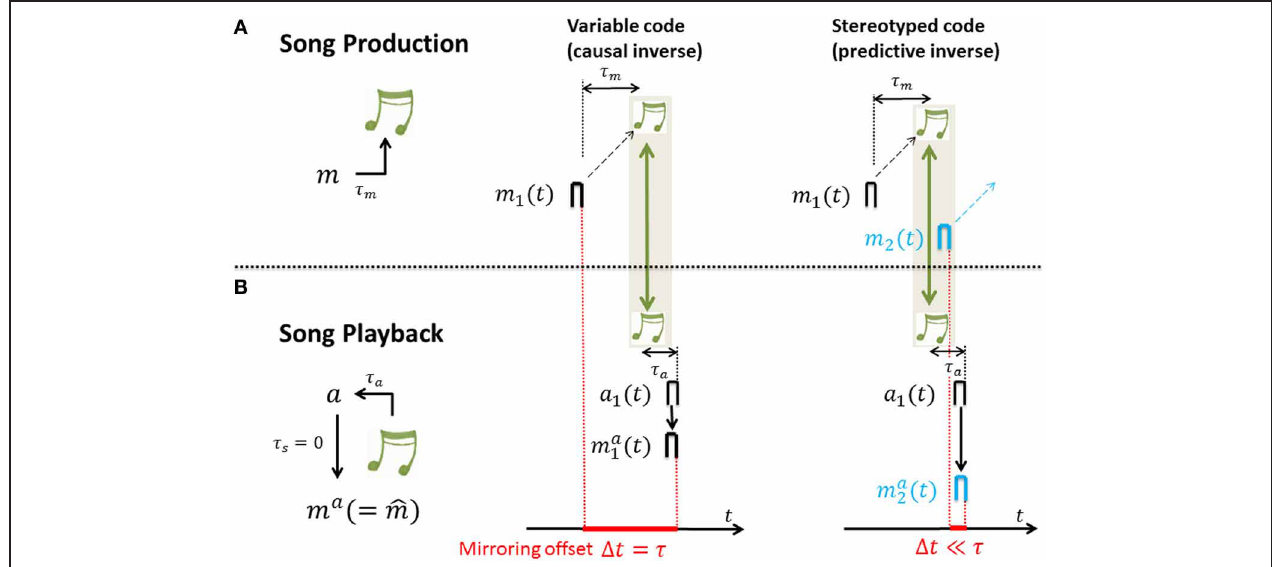
FIGURE 4 | The mirroring offset is determined in recordings of neural activity across (A) singing and (B) auditory stimulation by song playback; the offset (red) is large for causal inverses (middle column) and close to zero for predictive inverses (right column). (A) During singing, a motor-neuron burst m 1 drives a song feature (green notes) after a time delay τ m . (B) Playback of that song feature leads to auditory response a 1 after a time delay τ a . And, auditory response a 1 leads to motor neuron response m a 1 in case of a causal inverse (middle column) and to motor neuron response m a 2 in case of a predictive inverse (right column) after an additional time lag τ s (spike propagation time from auditory to motor area) that is assumed to be 0